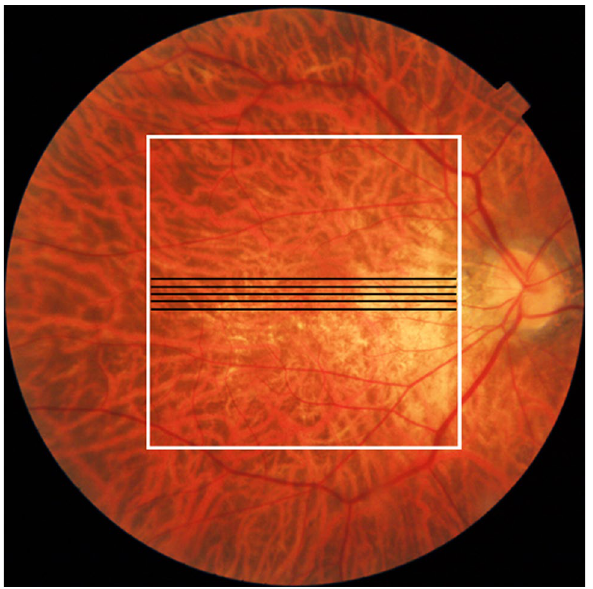
Figure 1. Measurement area in a color fundus image of the right eye of a 50-year-old woman with pathologic myopia. Black lines indicate five sets of macular scan lines of commercial OCT. The white line indicates the measurement area of